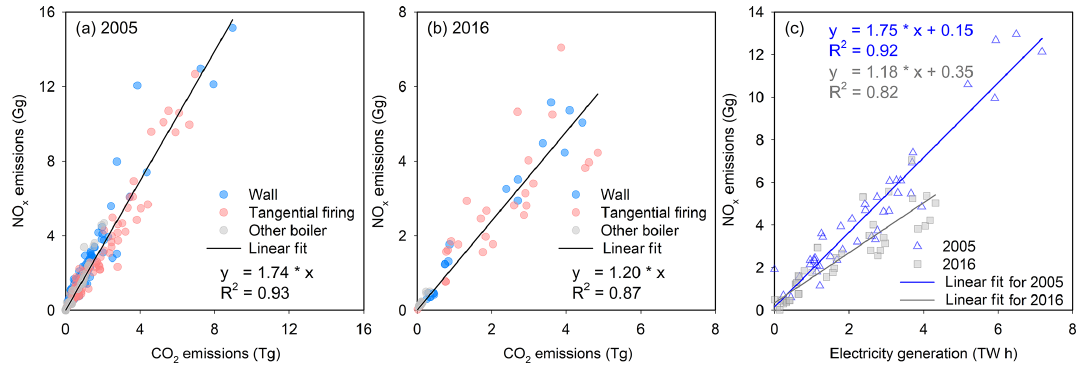
Figure 4. Scatterplots of E CEMS versus E CEMS for all the US bituminous coal-fired electric generating units for (a) 2005 and (b) 2016. NO x CO 2 Values are color coded by firing type. (c) Scatterplot of E CEMS versus electricity generation of the same units for years 2005 (triangle) and NO x 2016 (square). Only plants without post-combustion NO x control devices within a given year are used. The electricity generation data are also from eGRID. The lines in all three panels represent the computed linear regressions.